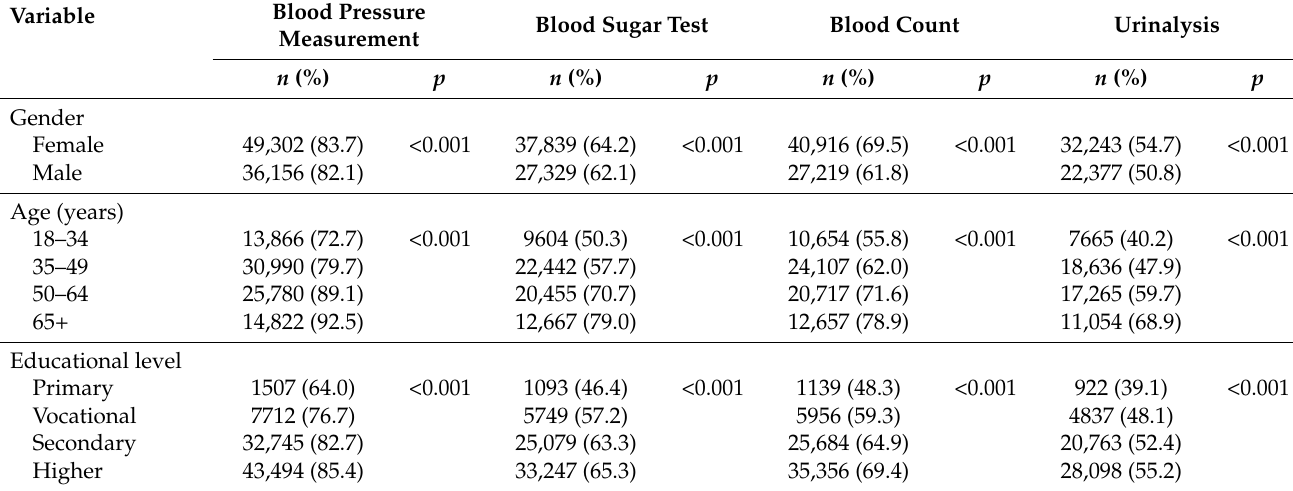
Table 3. Annual preventive health screening among adults in Poland by sociodemographic factors ( n =